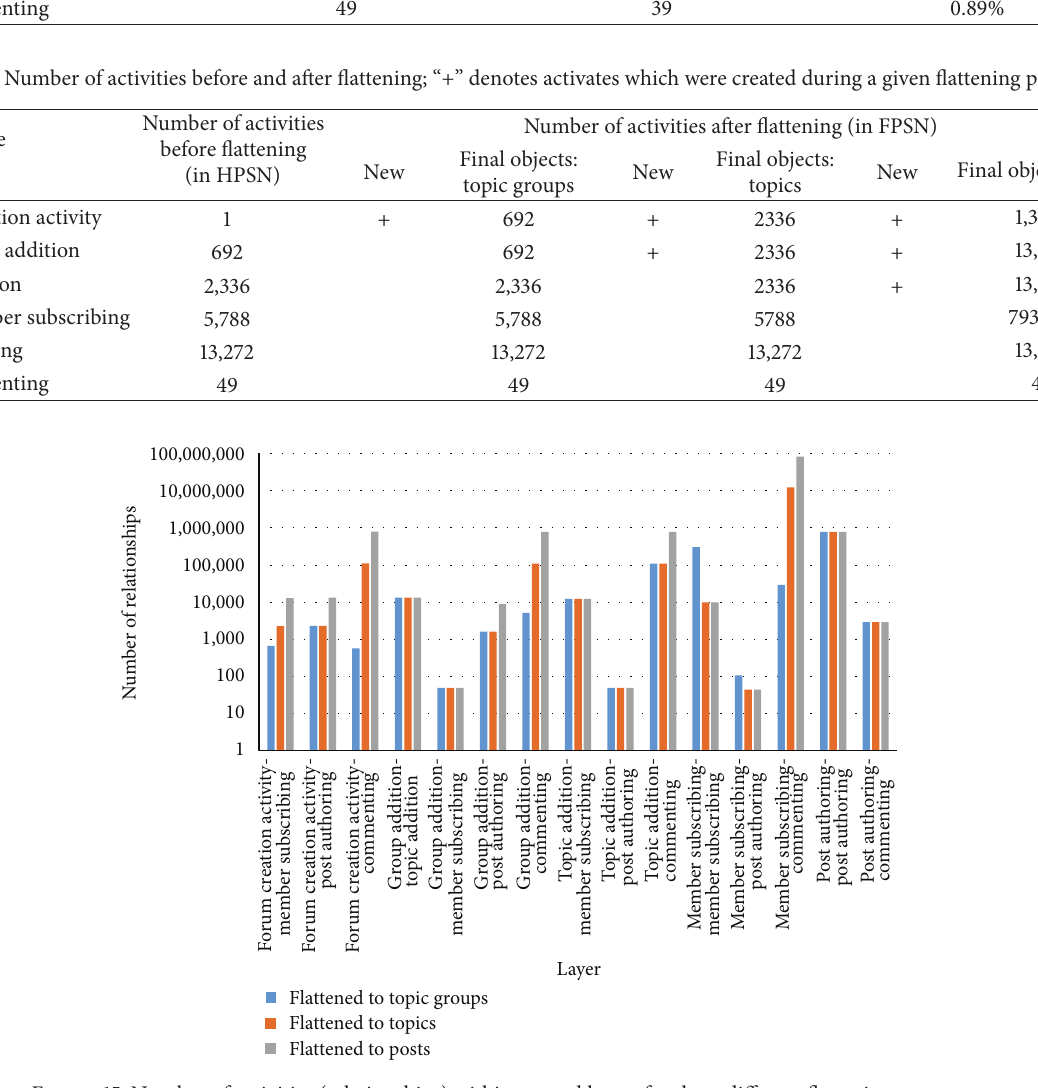
Figure 15: Number of activities (relationships) within created layers for three different flattening